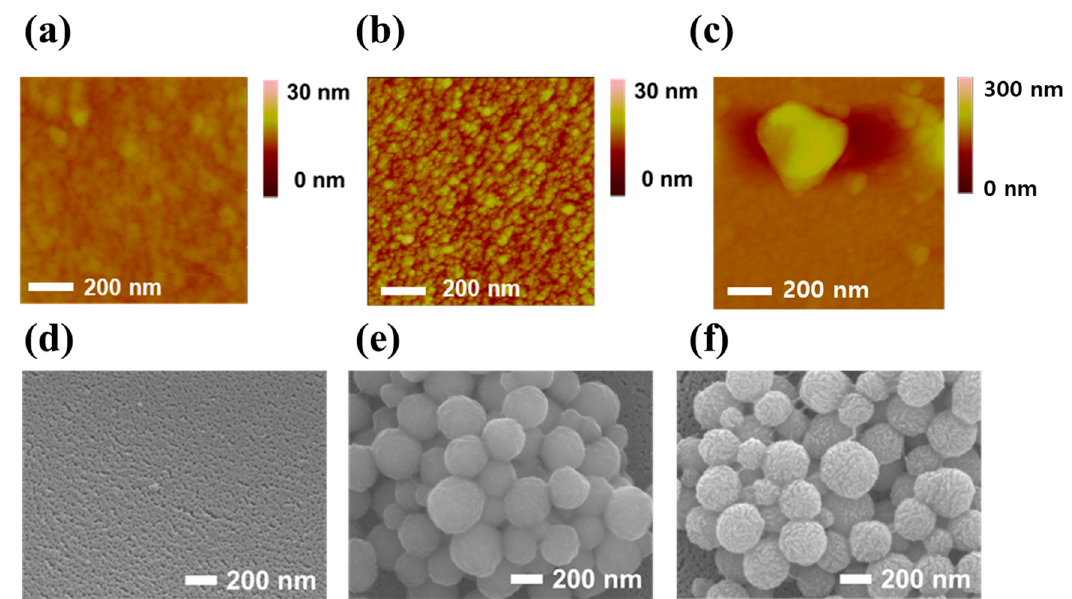
Figure 3. Atomic force microscopy (AFM) images of ( a ) the PET substrate, ( b ) Au sputter coated PET substrate, and ( c ) the Au / MoS 2 on the PET substrate, and SEM images of ( d ) Au sputter coated PET substrate, ( e ) the Au / MoS 2 on the PET substrate, and ( f ) the Au / MoS 2 / Au nanolayer on the PET substrate.